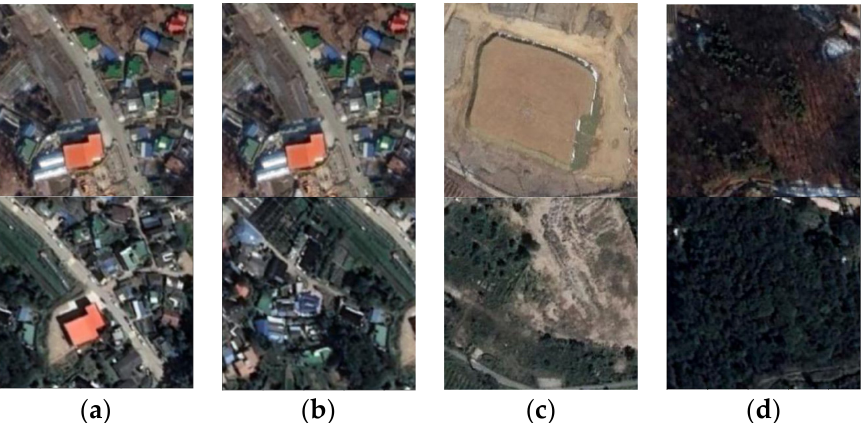
Figure 5. Examples of sub-images pairs. ( a ) is a matched pair, ( b – d ) are unmatched pairs.